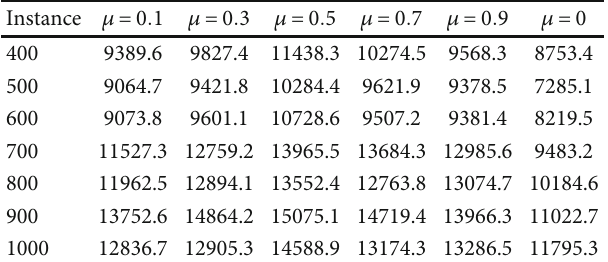
Figure 6: Average task competition performance. Table 7: Pro fi t under di ff erent weight update